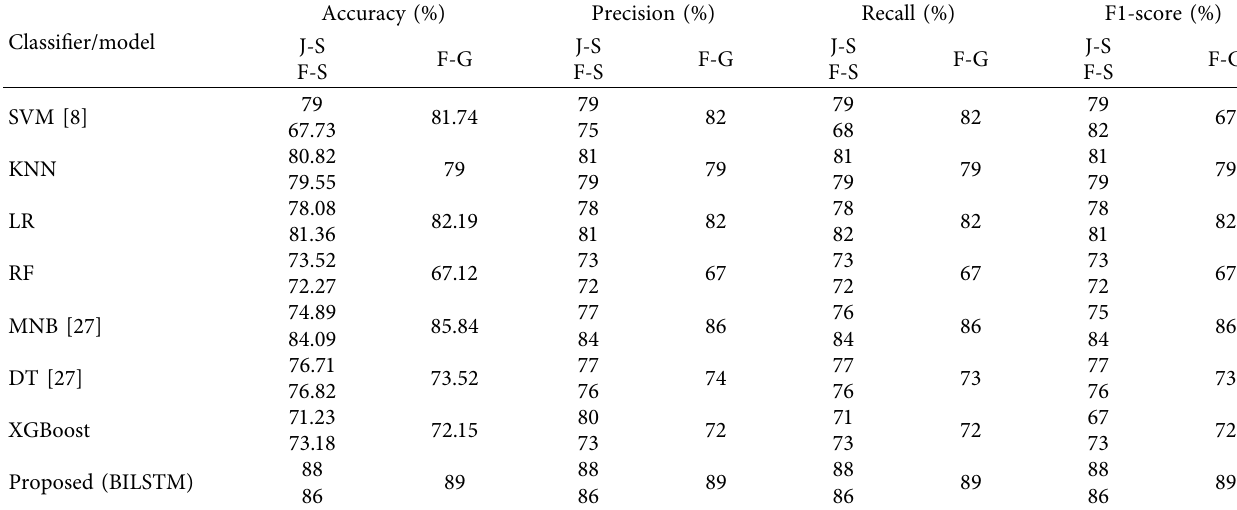
Table 9: Evaluation results of machine learning and the proposed